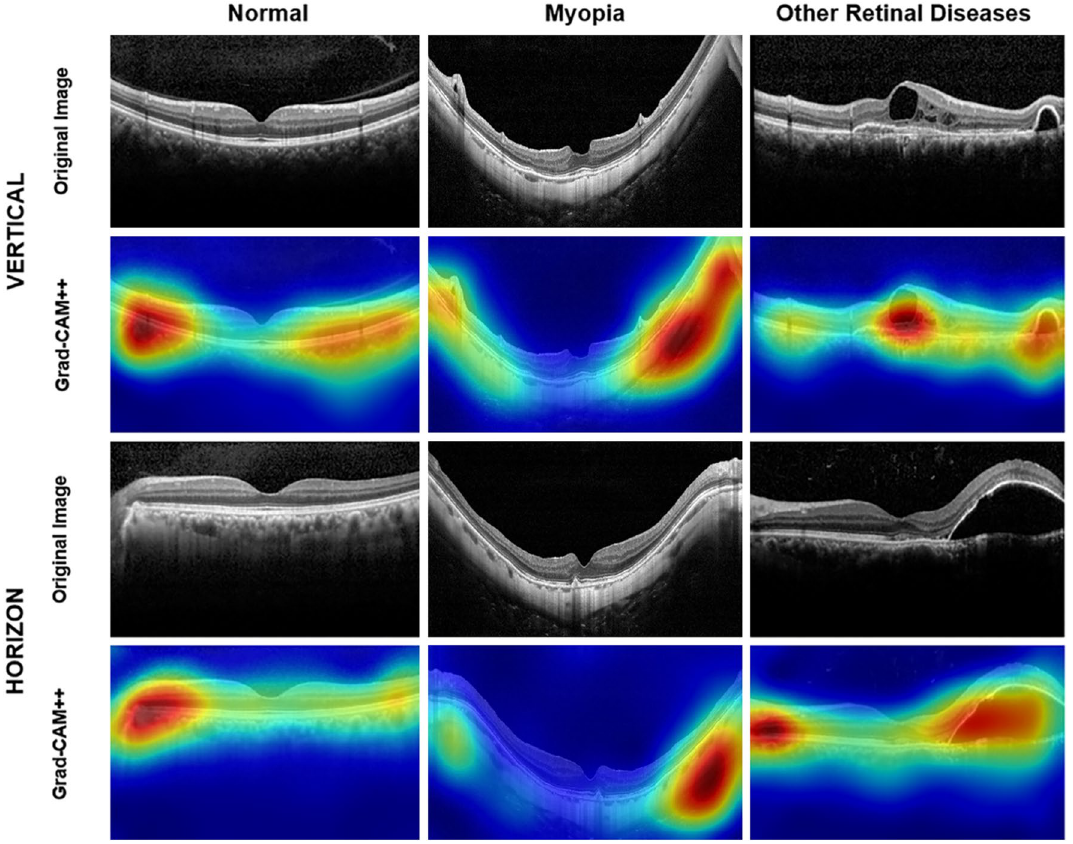
Figure 4. Visual explanations generated by Grad-CAM + + on OCT scans. The Grad-CAM + + image show that the deep learning model accurately identified the differentiation